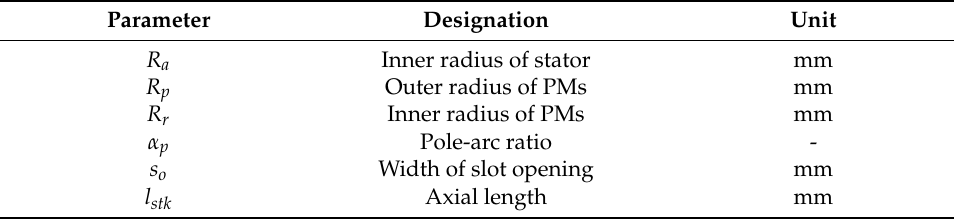
Figure 4. Simplified analytical model. Table 2. Parameters of simplified analytical model.